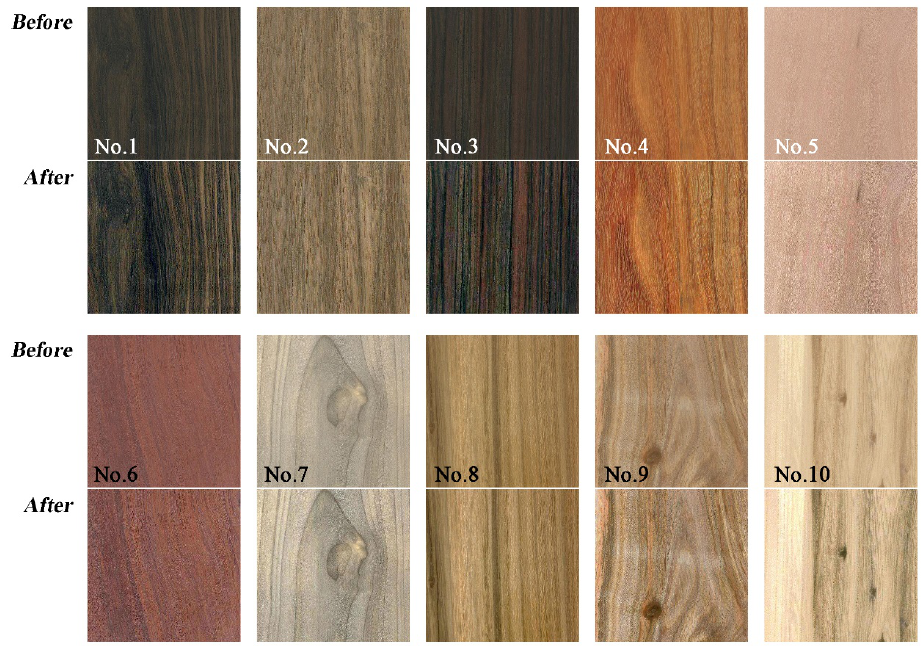
Figure 5. Ten Gaussian hardwood grain images before and after the adaptive color